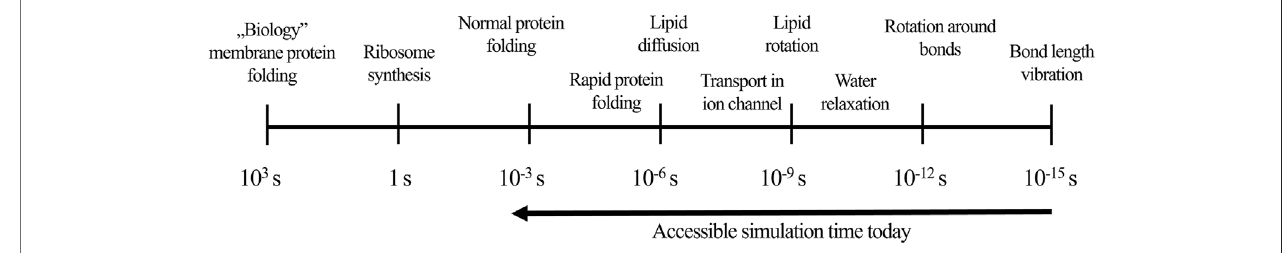
FIGURE 1 | The in fl uence of simulation time on events occurring during MD (according to Lindahl, 2008).